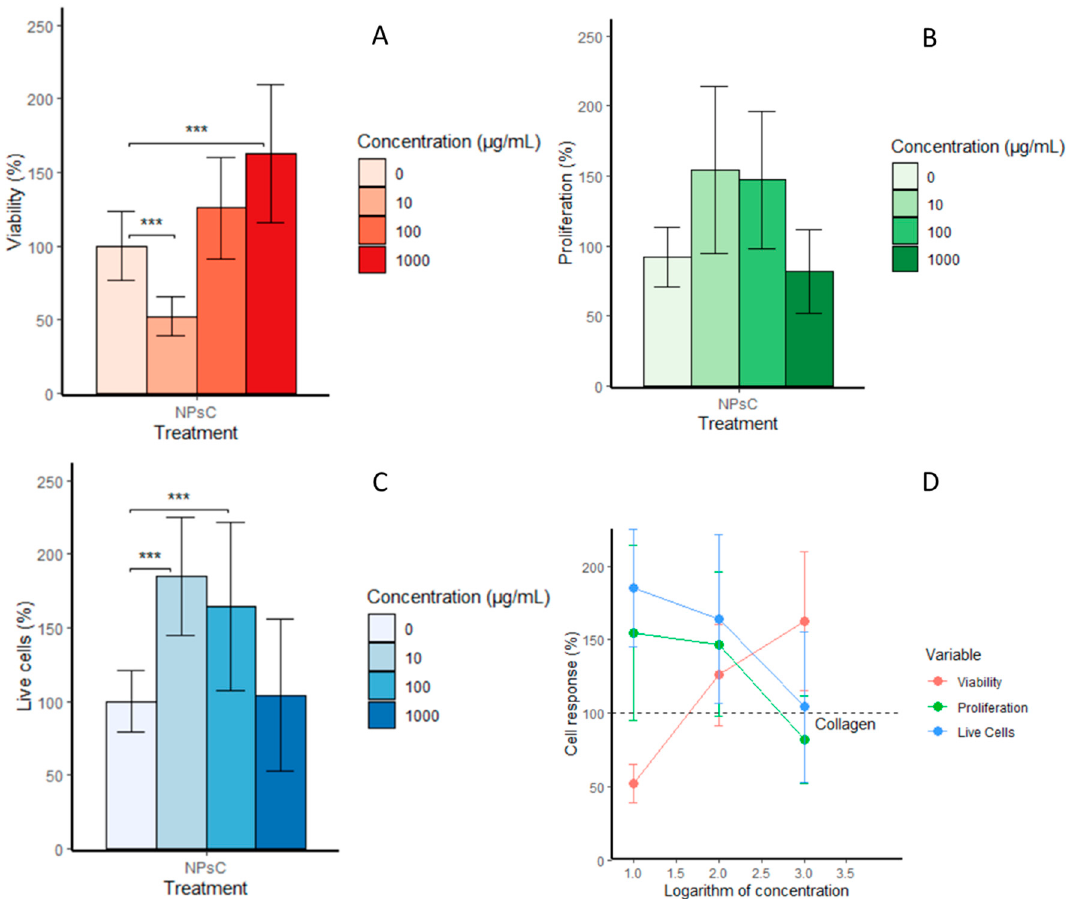
Figure 7. ( A ) Cell viability of 3T3 cell line incubated with collagen and collagen impregnated with propolis NPs at concentrations of 10, 100, and 1000 μ g/mL (mean % ± SD). ( B ) Total cell count means determined using a proliferation assay. ( C ) Number of living cells. ( D ) Correlation of cell response and propolis NP concentration. Significant differences at p ≤ 0.05 are indicated by a line and asterisks (***). Significance was determined using an analysis of variance (ANOVA) test.